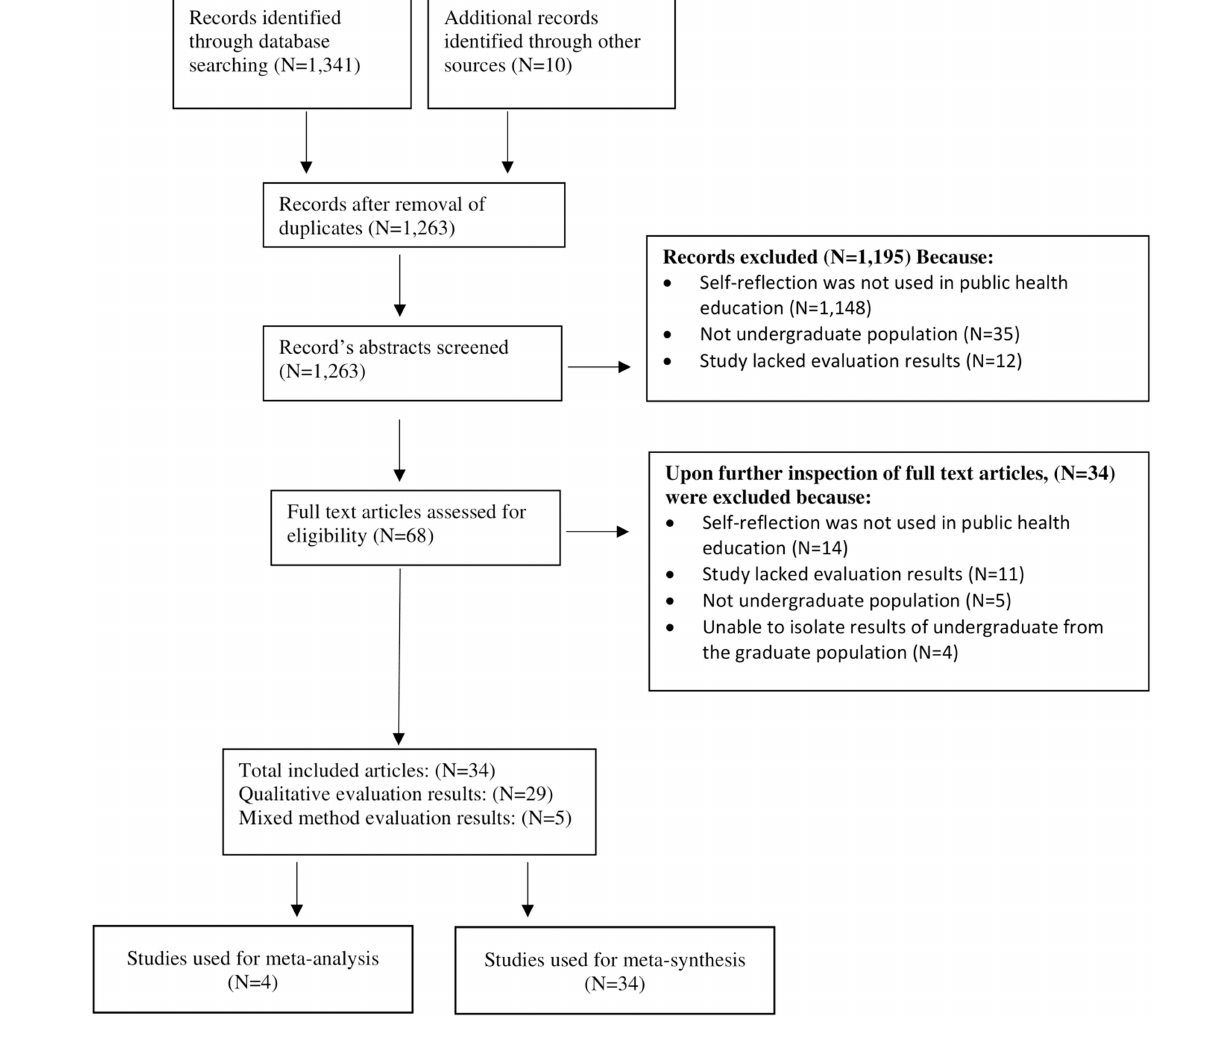
FIGURE 1 | Article selection process for the systematic